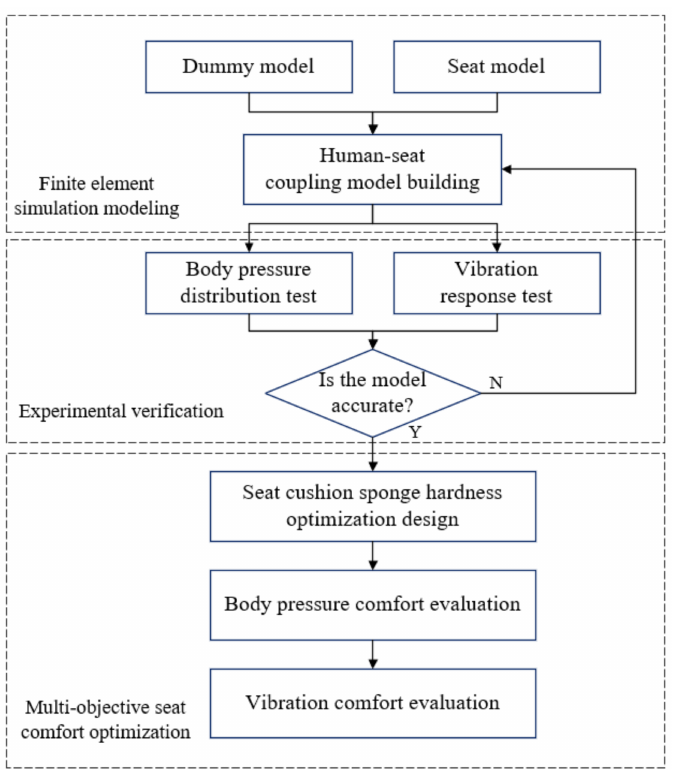
Figure 1. Human-seat coupling system comfort evaluation and optimization